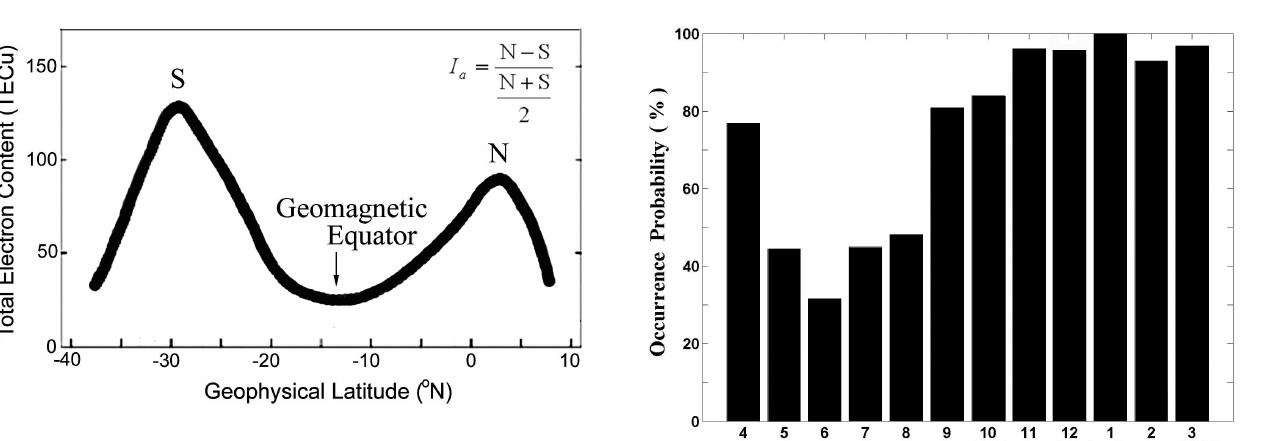
Fig. 3. Schematic illustrating a typical latitudinal distribution of VTEC values. The equation of an asymmetry index I a of the EIA is represented in the upper-right corner.